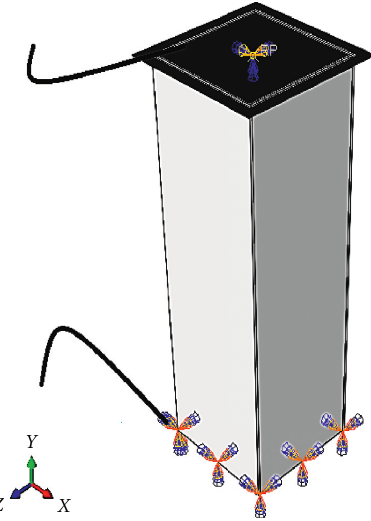
Figure 3: Sample validation modeling of Bombach et al.